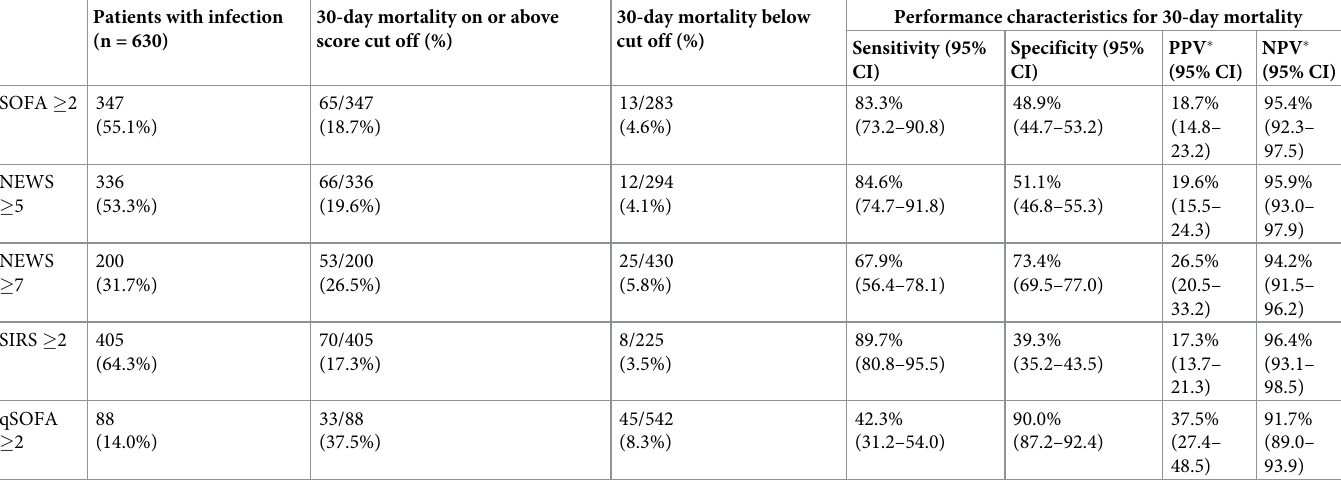
Table 3. Severity scores and performance characteristics for 30-day mortality from onset of infection. Patients with infection (n =